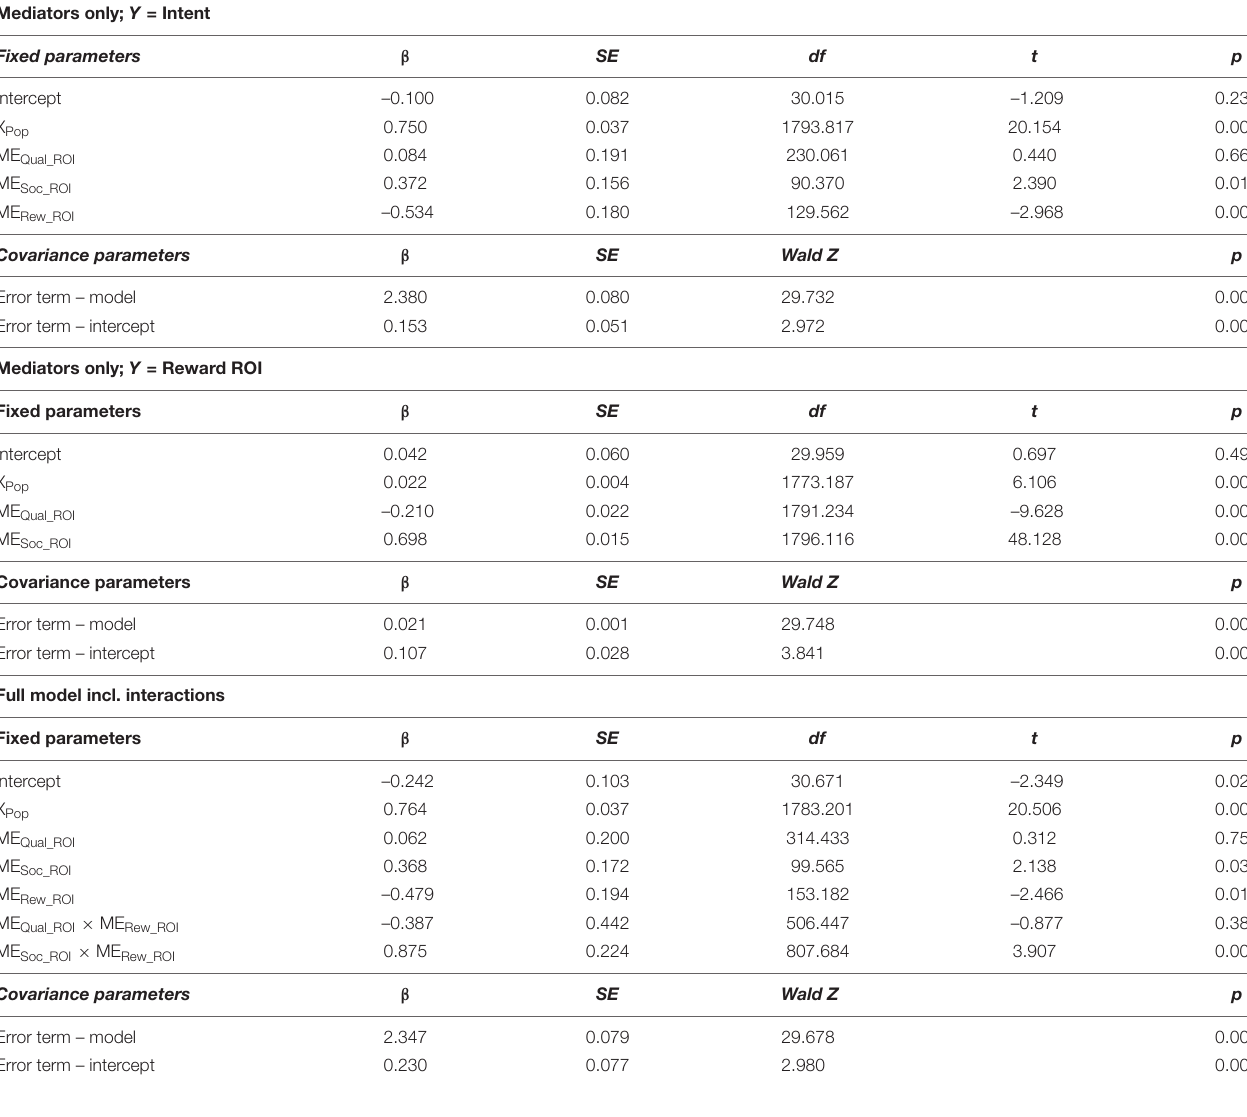
TABLE 2 | Parameters and test statistics for social